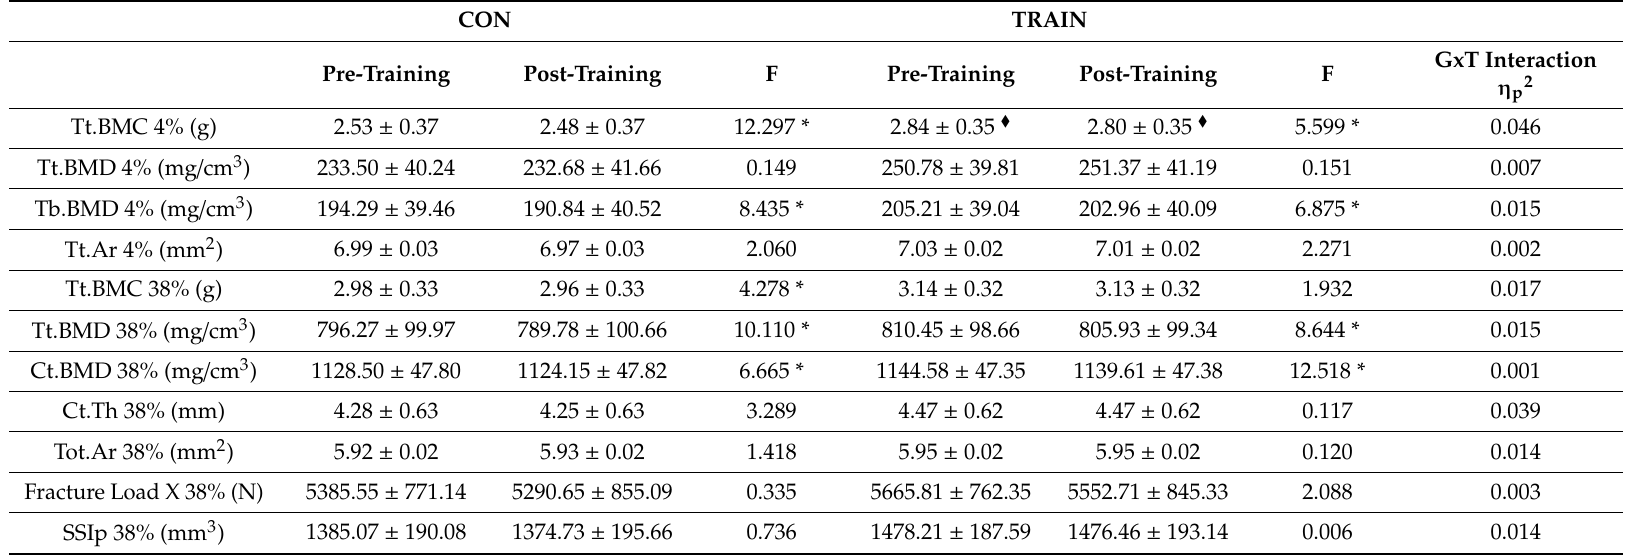
Table 2. Bone variables in CON and TRAIN groups at pre-training and post-training periods adjusted by age and sex. CON TRAIN Pre-Training Post-Training F Pre-Training